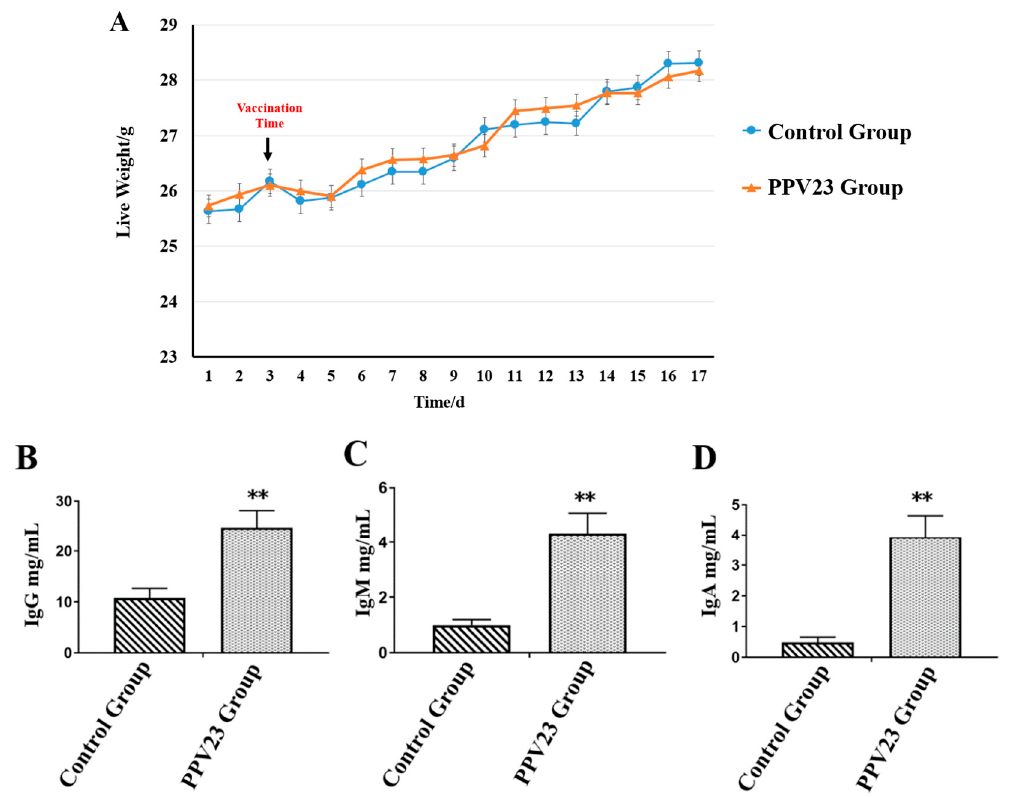
Figure 1. Phenotypic data analysis of mice between control group and PPV23 treatment group (n = 12). ( A ) Analysis of mice live weight during the experiment periods. ( B ) Serum immune factor concentration of IgG. ( C ) Serum immune factor concentration of IgM. ( D ) Serum immune factor concentration of IgA. ** indicates significant differences ( p < 0.01)